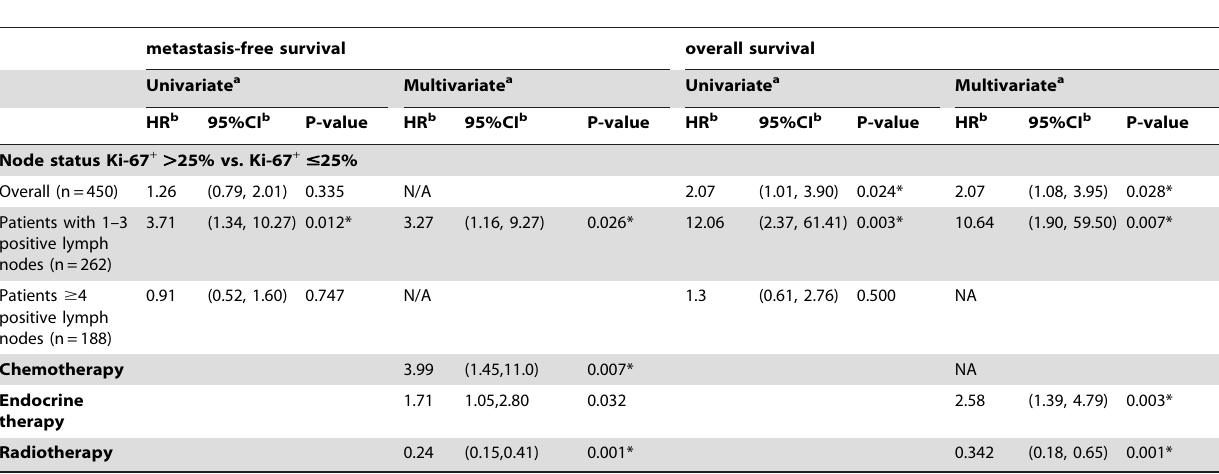
Table 2. Cox proportional hazards regression analysis of potential prognostic factors for Metastasis-free survival and overall